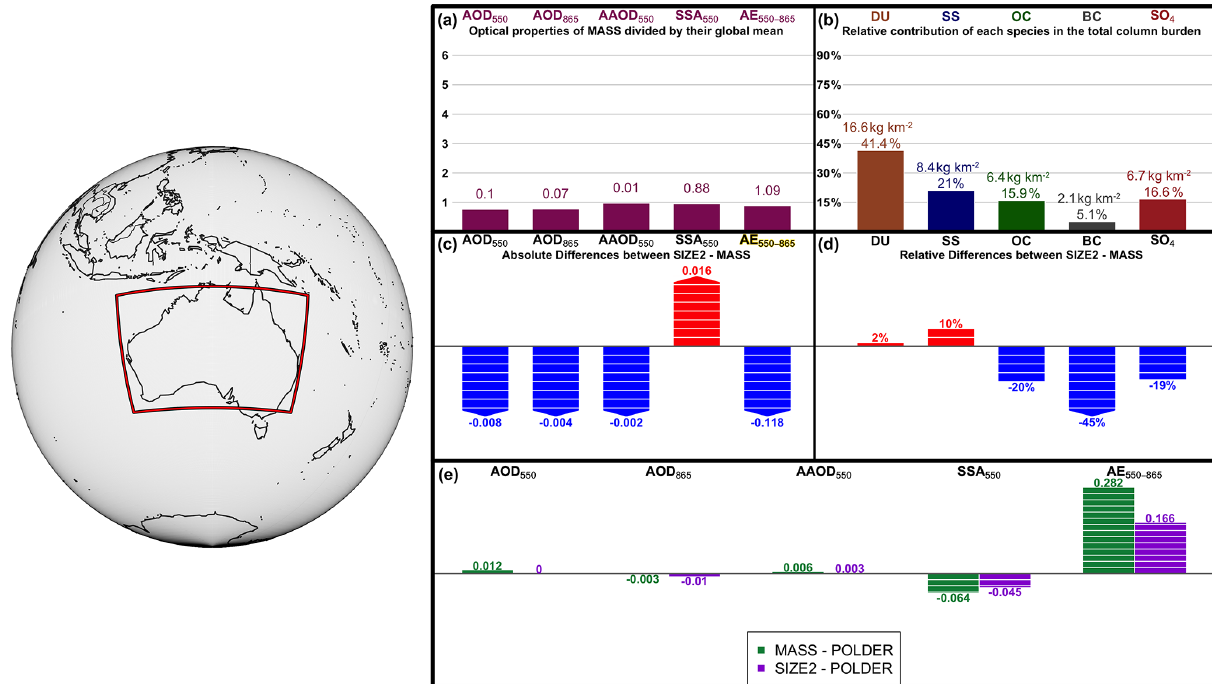
Figure 13. An overview of the changes due to the addition of POLDER AE 550 − 865 in the assimilation for Australia. Panel (a) depicts the mean values of five aerosol optical properties, while the height of bars indicates the regions relative amount of each property in comparison to the global mean. Panel (b) illustrates the column burden of five aerosol species as simulated in the MASS experiment. The percentage in the column burdens of each species specifies the relative contribution of each species in the total column burden. Panel (c) illustrates the absolute changes caused in aerosol optical properties, due to the assimilation of AE 550 − 865 (SIZE2 – MASS), while the height of bars indicates if the change is just positive or negative. Panel (d) shows the relative changes caused in the mixing ratio for each species due to the assimilation of AE 550 − 865 (SIZE2 – MASS). Panel (e) displays the aerosol optical properties’ bias in comparison to POLDER for the MASS and SIZE2